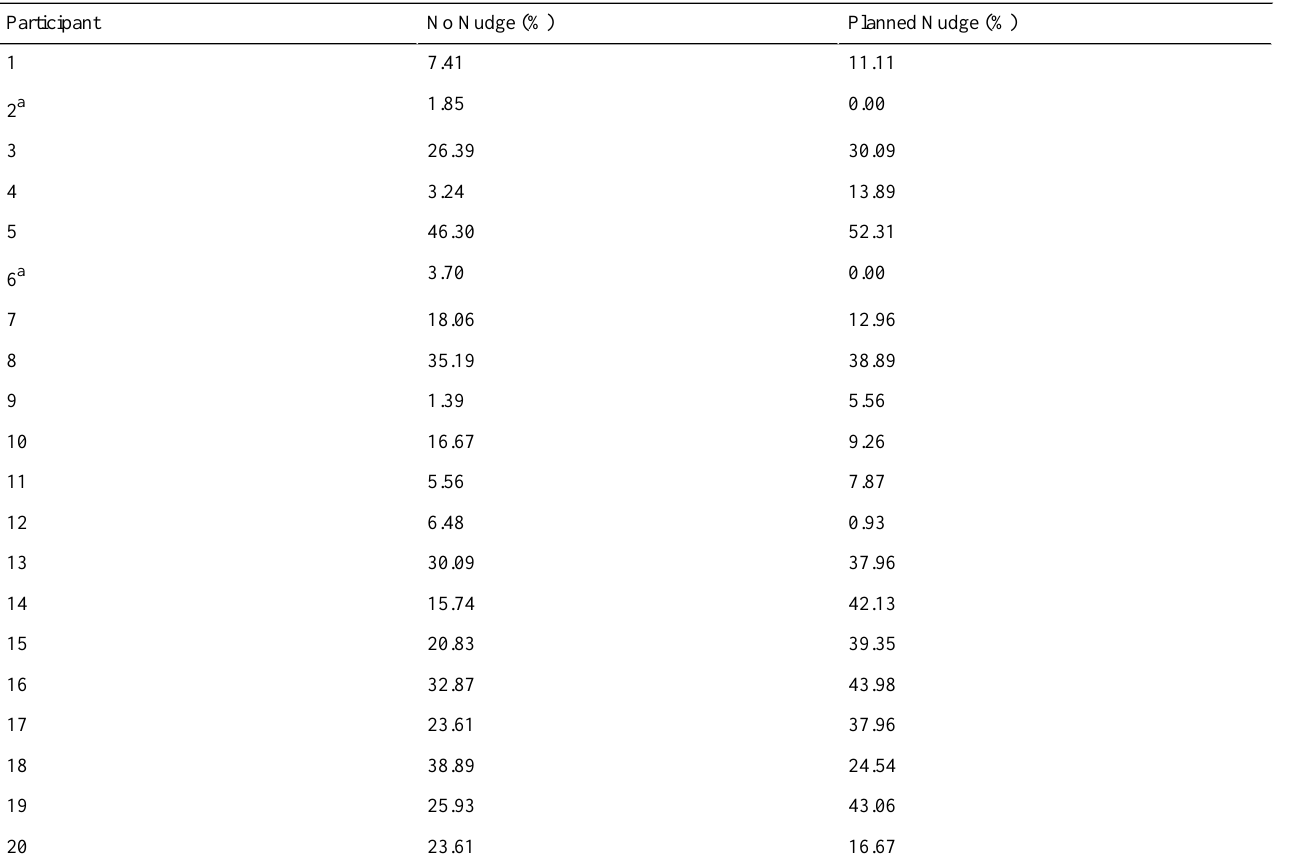
Table 3. Proportion of observations with affected upper limb movment (unilateral affected upper limb movement + bilateral limb movement + bimanual movement) following No Nudge and Planned